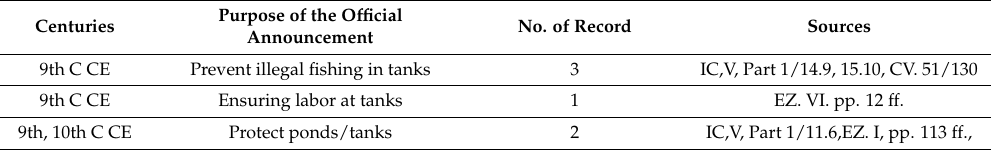
Table 5. Categories of official announcements on irrigation mentioned in ancient